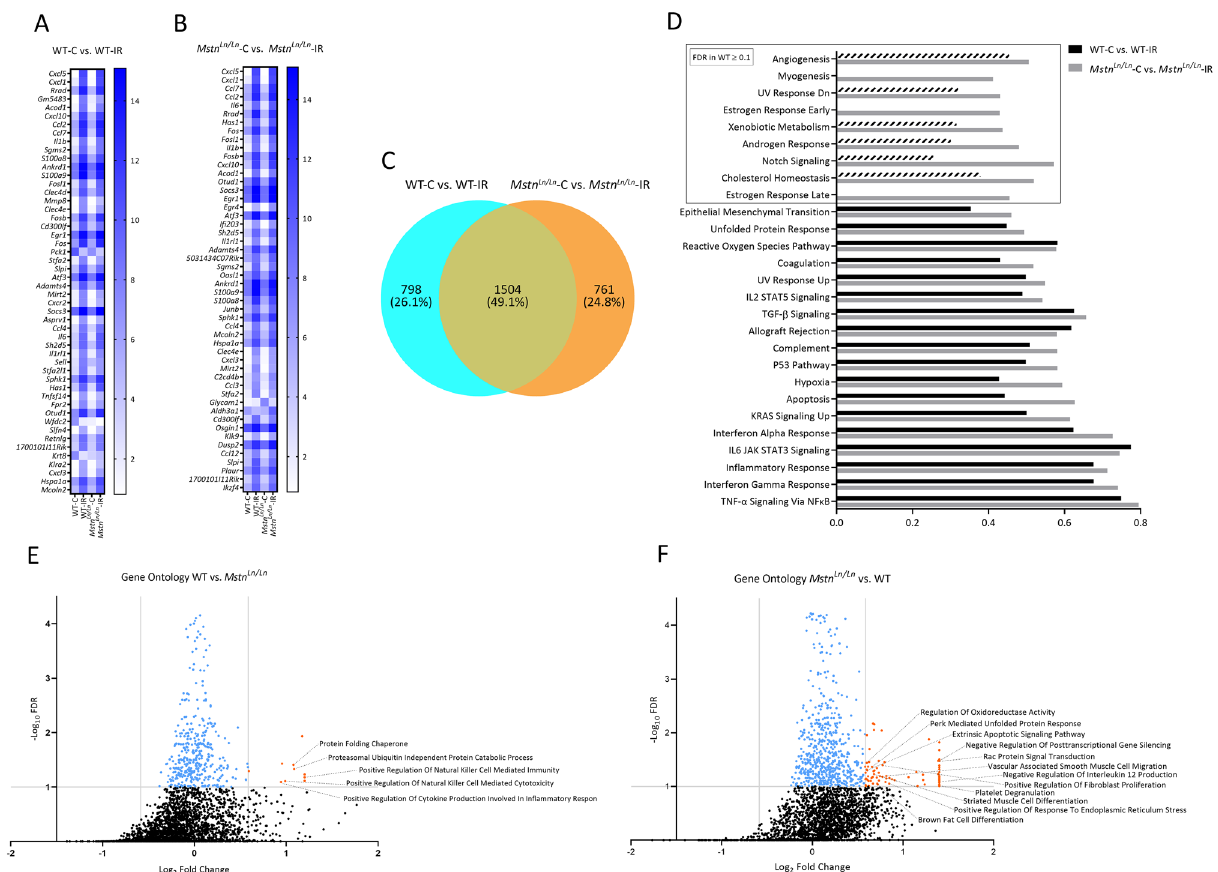
Figure 4. Transcriptional profiling of IR injury alleviation in WT Mstn Ln/Ln mice. Heatmap depicting expression values of 50 DEGs (expression values within the 50th–100th percentile, fold change ≥ 1.7, FDR (Benjamini– Hochberg) < 0.05) sorted by descending fold change due to IR injury in ( A ) WT or ( B ) Mstn Ln/Ln mice. ( C ) Venn diagram illustrating the overlap between genes that are differentially expressed due to IR injury in WT or Mstn Ln/Ln mice, respectively. ( D ) GSEA with the hallmark gene set comparing enriched gene sets after IR injury in WT (WT-C vs. WT-IR) and Mstn Ln/Ln ( Mstn Ln/Ln -C vs. Mstn Ln/Ln -IR) mice. Enrichment scores inside the box are non-significant in WT mice at an FDR-threshold of 0.1. ( E ) GSEA of GO terms BP and MF comparing WT and Mstn Ln/Ln mice before and after IR injury. Blue dots mark enrichment scores that are below the FDR- threshold of 0.1. Orange dots mark values that also meet the fold change cut-off of 1.5 when comparing the enrichment score of Mstn Ln/Ln -C vs. Mstn Ln/Ln -IR mice with the enrichment score of WT-C vs. WT-IR mice for a given gene